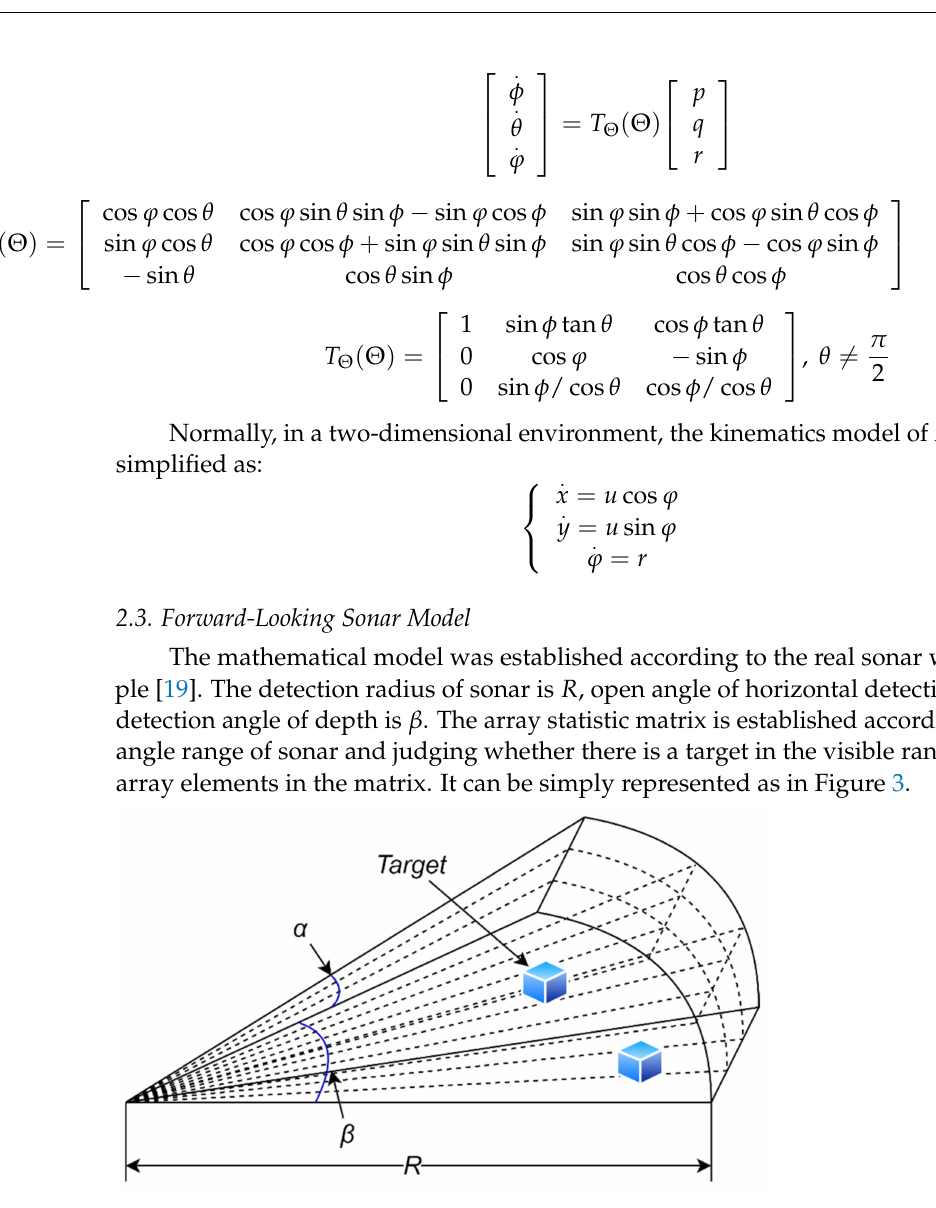
Figure 3. Simplified sonar